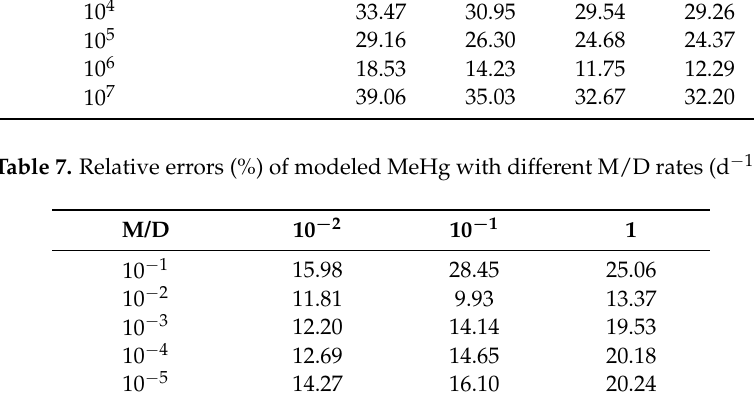
Table 6. Relative errors (%) of modeled DHg with different values of K d (L · kg − 1 ). K d for Fine Solids/ K d for Coarse Solids